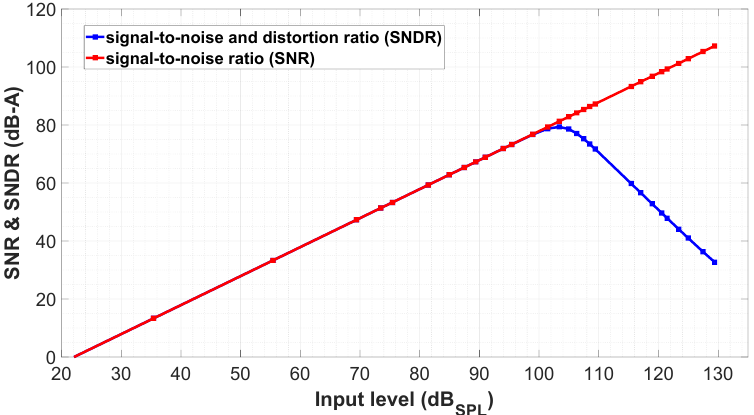
Figure 9. Simulated analog core dynamic range in the differential configuration for different input levels referred to 94 dB SPL = 12 mV rms (A-Weighting filter